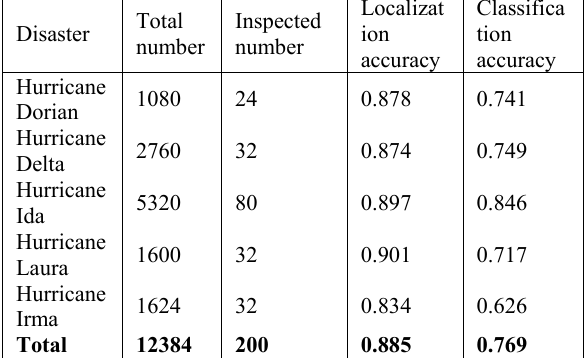
This contribution has been peer-reviewed. https://doi.org/10.5194/isprs-archives-XLVIII-3-W1-2022-65-2022 | © Author(s) 2022. CC BY 4.0